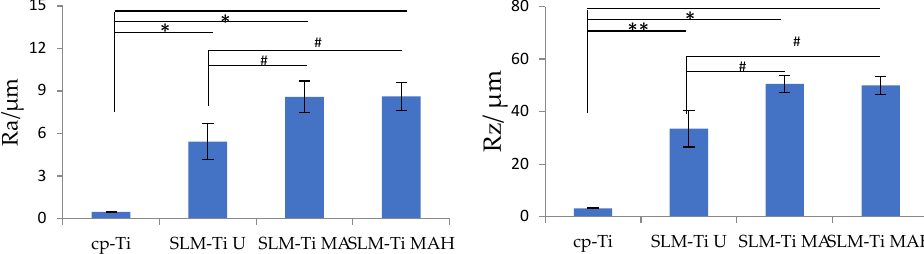
Figure 2. Surface roughness parameters of cp-Ti and SLM-Ti before and after treatment with mixed acid and heat. Ra: the average peak to valley distance, Rz: the highest peak to the lowest valley distance. Different from cp-Ti at * p < 0.05, ** p < 0.01; # different from SLM-Ti U at # p < 0.05.